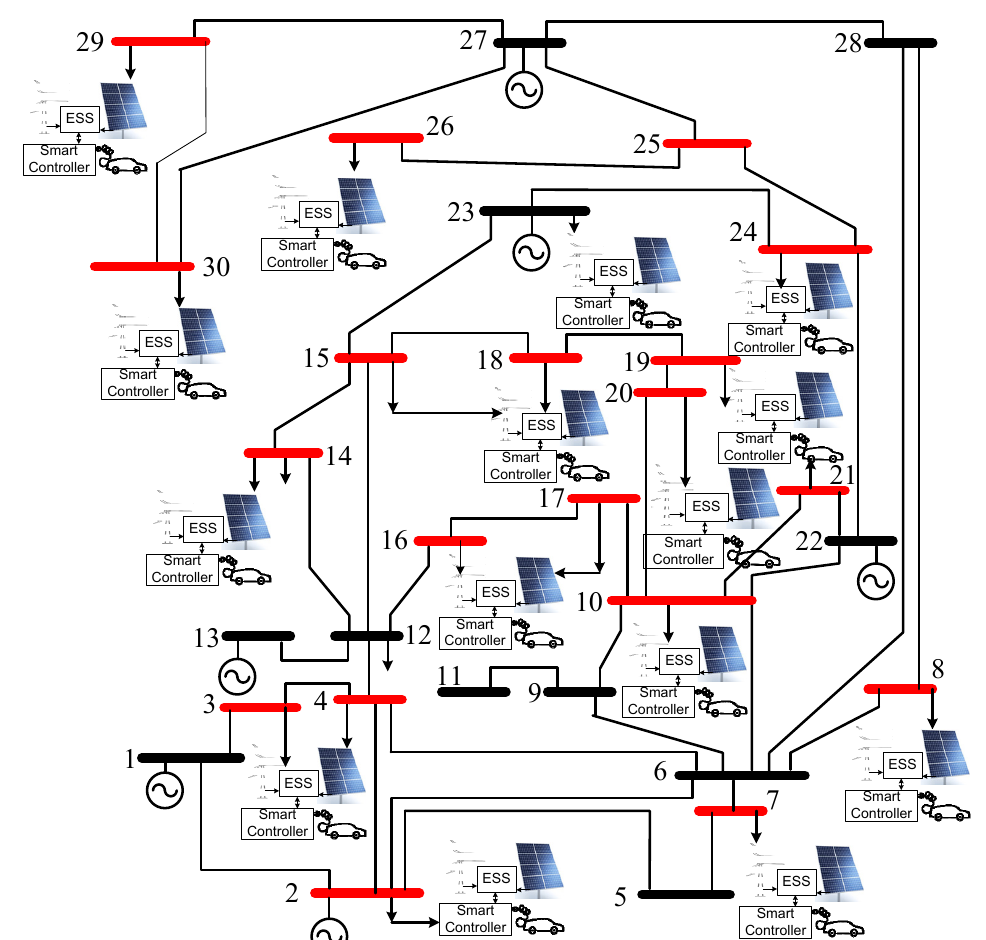
Figure 7. The schematic diagram of the IEEE 30 bus system with SEVCS connected to each load bus. Two different constraints should be applied to the solution of the OPF of power system: equality constraints and inequality constraints. The real and reactive powers at any busbar depend on its voltage and the other voltages connected to it through the shown in Equations (42) and (43), respectively